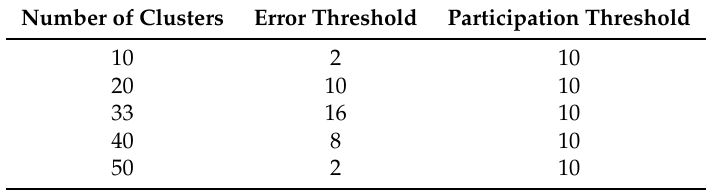
Table 2. Hyperparameters used for the Micro-Cluster Nearest Neighbor (MCNN). Number of